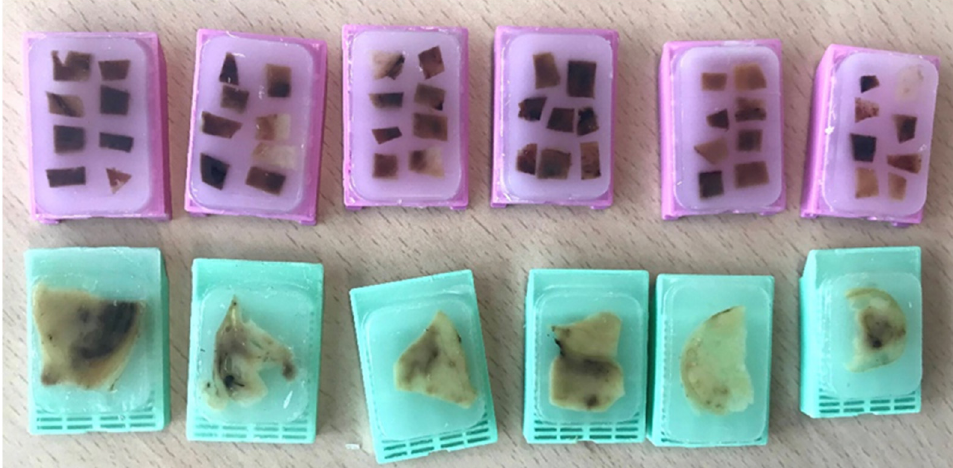
Figure 2. Multisite tumor sampling (pink blocks) consists on including six to eight small tumor tis- sue fragments in each paraffin block instead of one large tumor fragment proposed by the classic protocol (green blocks). This way, the same number of paraffin blocks sample many more tumor regions.